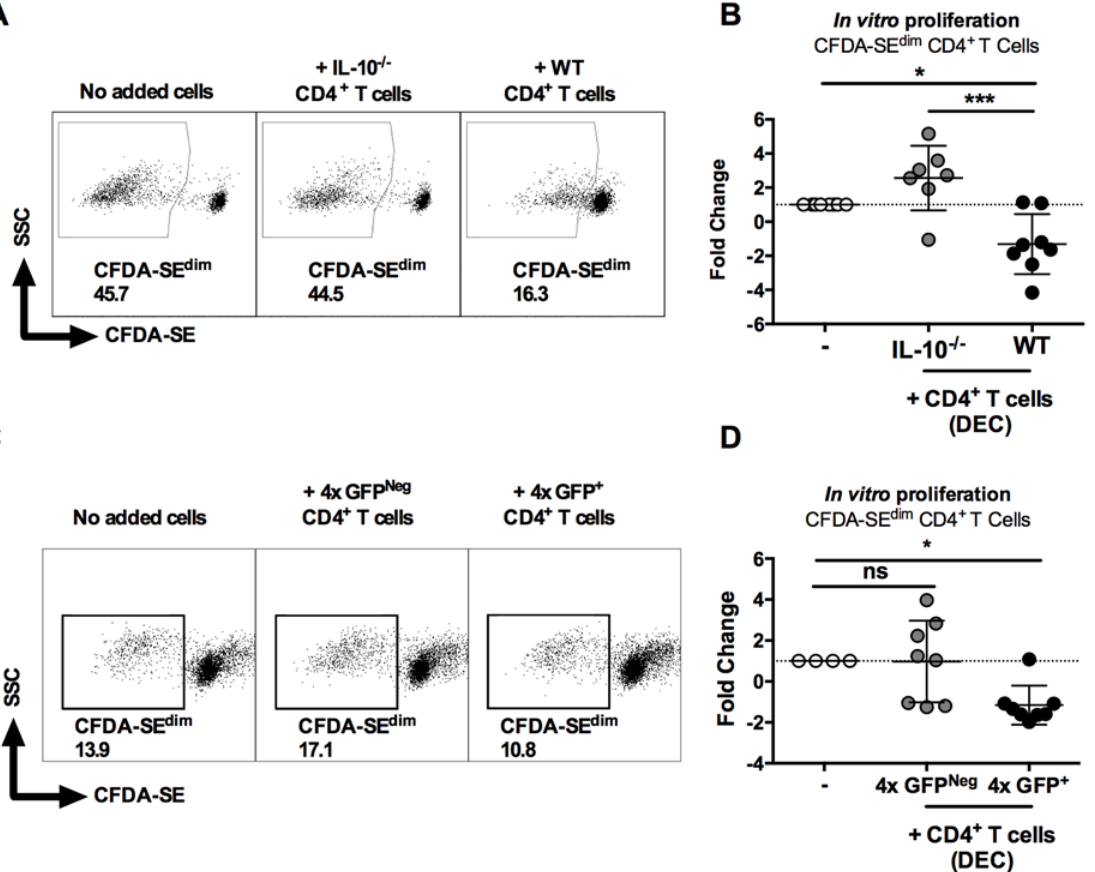
Fig 6. IL-10 GFP+ CD4 + T cells from the skin of mice infected with S . mansoni suppress proliferation of CD4 + T cells in the skin draining lymph nodes. ( A ) Representative flow cytometry dot plots of CFDA-SE dim CD3 + CD4 + cells from the sdLN of 1x infected mice after co-culture for 96h with dermal CD4 + T cells from 4x infected WT or IL-10 -/- mice in the presence of parasite antigen SSAP. ( B ) Data is given as sdLN CD3 + CD4 + T cell proliferation expressed as the fold-change observed in each of seven corresponding mice co-cultured in the presence of dermal CD4 + T cells from either WT or IL-10 -/- mice relative to sdLN CD3 + CD4 + T cells cultured without added dermal CD4 + T cells. Symbols are individual mice; horizontal bars are means ± SEM; n = 7. ( C ) Representative flow plots and ( D ) fold change ± SEM of CFDA-SE dim sdLN CD3 + CD4 + T cells from 1x infected mice (n = 8) co-cultured with GFP + , or GFP Neg dermal CD4 + T cells from 4x infected mice in the presence of SSAP. Differences between the means of selected groups were compared by ANOVA and Tukey ’ s multiple comparisons test analysis ( * = p < 0.05; ** = p < 0.01; *** = p < 0.001; **** = p < 0.0001; ns = p >